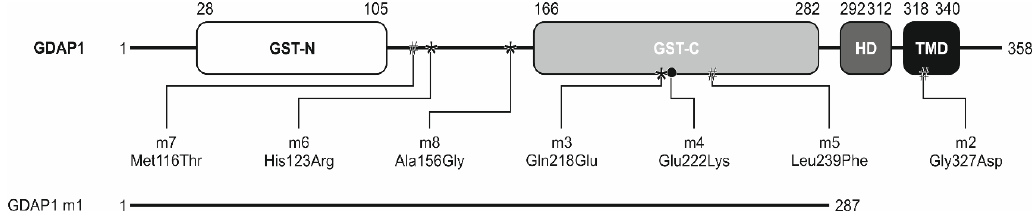
Figure 1. Schematic representation of the GDAP1 domain structure. Studied protein changes are indicated. GDAP1 m1 is a truncated version of GDAP1, lacking the domains responsible for correct localization of the protein (HD and TMD). Dominant mutations leading to the given substitution are flagged by stars (*) and recessive instances by a hashtag (#). GDAP1 m4, which may be inherited in both dominant and recessive ways, is indicated by dot ( • ). Domains (based on Pfam database): (GST) glutathione S-transferase domain; (HD) hydrophobic domain; (TMD) transmembrane domain.